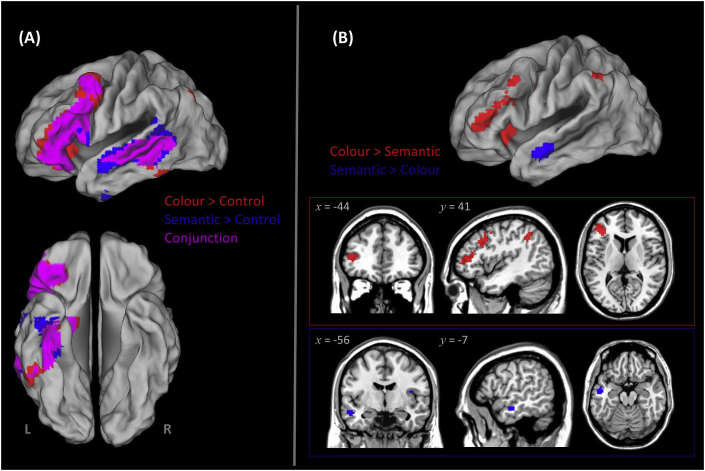
Results of whole-brain analysis, stringently thresholded at p < .05 (family-wise error corrected for multiple comparisons) for clusters and p < .0001 for voxel intensity. (A) Regions showing significantly greater activation for arbitrary pairing by canonical colour than control (red), semantic pairing by usual meaning than control (blue), and conjunctions of the two contrasts (magenta). (B) Clusters showing significantly greater activation for colour pairing than semantic pairing (red) and the reverse contrast (blue). Shown in the inset boxes are left frontoparietal clusters (the ‘control’ module) more active for colour pairing (red) and left anterolateral temporal cluster sensitive to semantic pairing (blue).